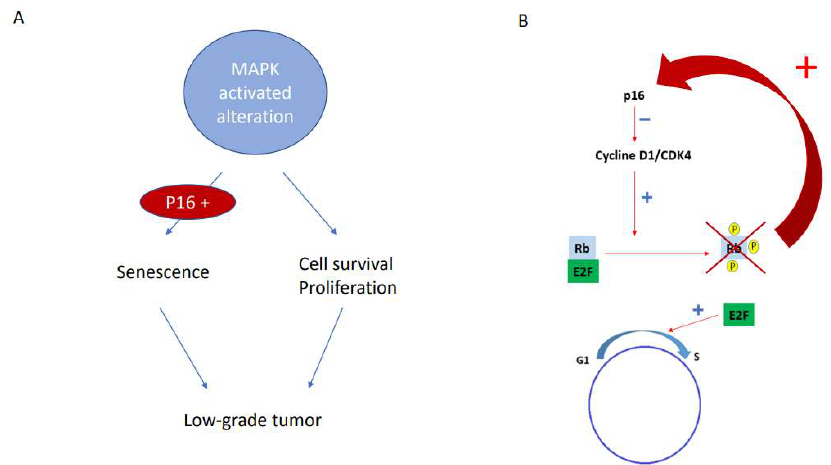
Figure 4. Schematic representation of the Oncogene-induced Senescence (linked to the activation of the MAPK pathway) leading to low-grade tumors ( A ). Schematic representation of p16 overexpression in high-grade gliomas linked to the positive feedback related to RB1 deletion ( B ). Regarding the CDKN2A FISH results, homozygous deletions were mostly found in IDH -wt GBM, IDH -mutant 1p/19q OG (grade 3), and H3K27-altered gliomas. No homo- zygous deletions were identified in IDH -mutant high-grade astrocytomas. The prognostic